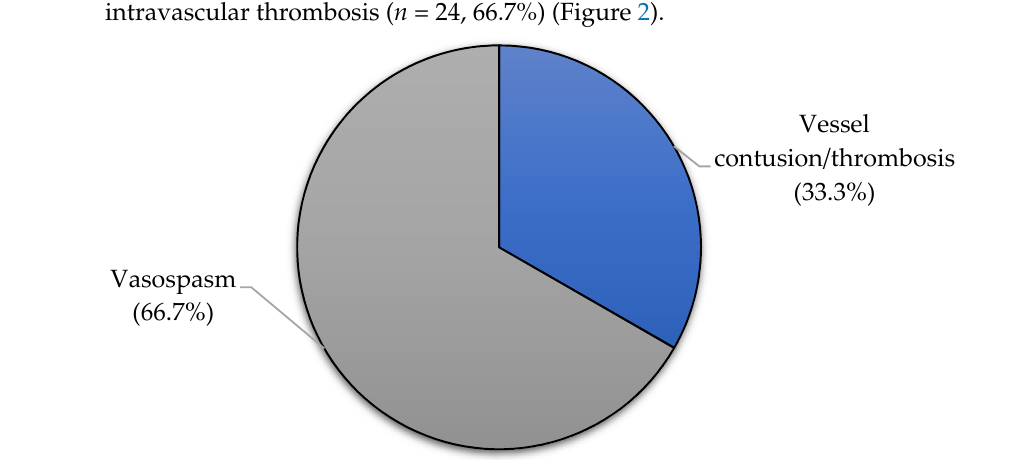
Figure 2. Intraoperative blood vessel injury in pediatric patients undergoing surgical treatment. No patients under 3 years of age had anatomical damage of the vessel wall, while there were two patients over 13 years of age who were diagnosed with vessel wall contusion. Of the cases with long-segment lesions on multislice CT-A ( ≥ 5 mm) that were operated on, only one-third of the lesions were actually vascular contusion. Preoperative Doppler spectrum analysis was not consistent with the severity of intraoperative brachial artery injury. Out of 24 patients with vasospasm, we performed intraoperative vascular